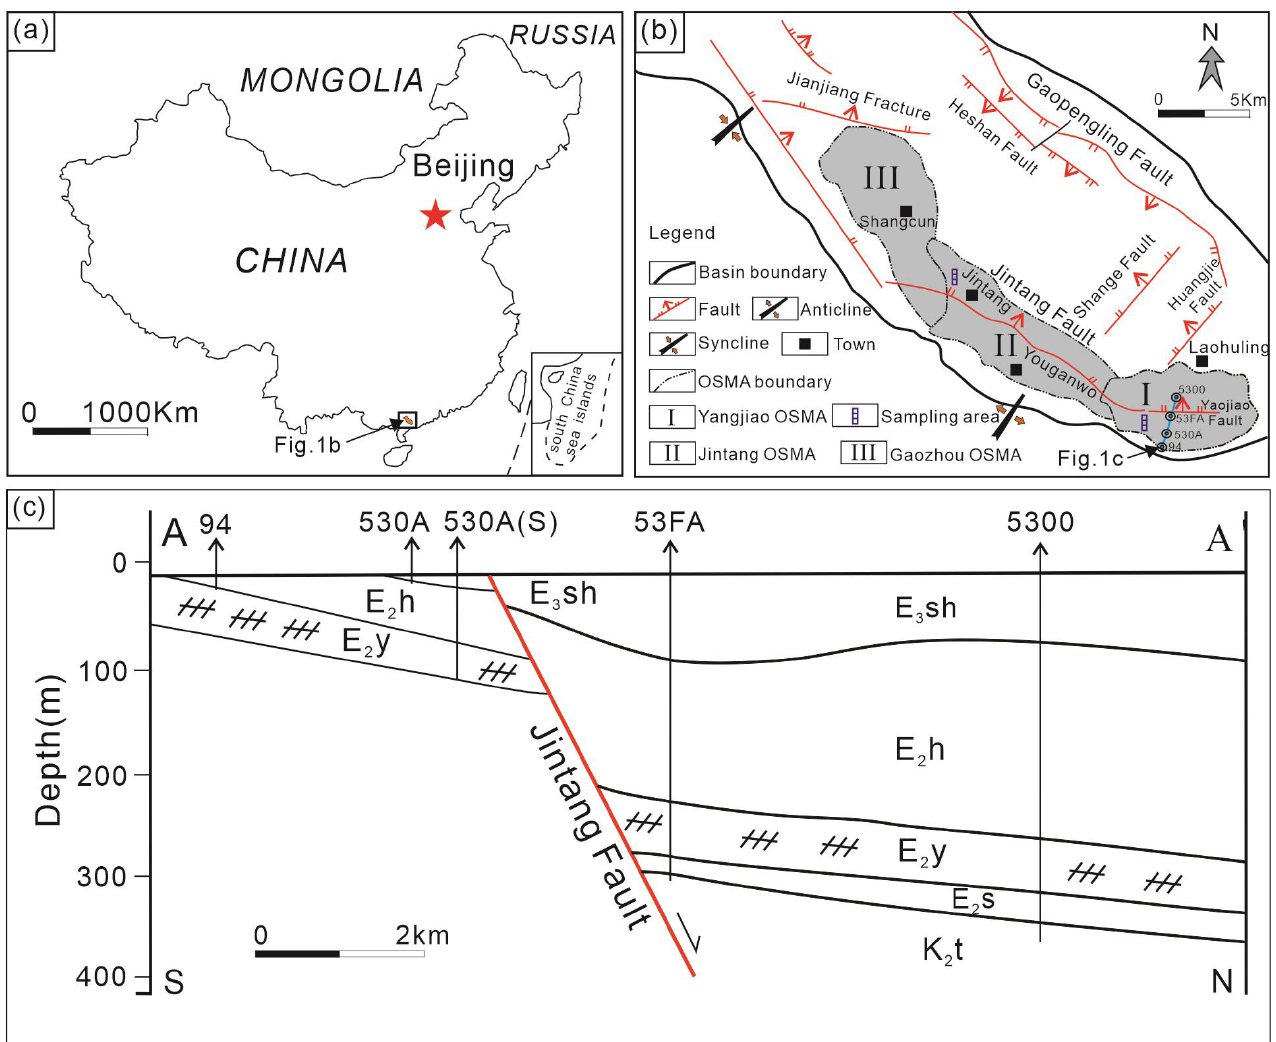
Figure 1. Regional location and mining area distribution map of Maoming Basin: ( a ) Location of Maoming Basin; ( b ) tectonic outline and oil shale mining areas distribution of Maoming Basin; ( c ) cross-sectional profiles of the study area showing the oil shale distribution controlled by the Jintang fault, locations of cross-sections are shown in ( b ). Abbreviations: OSMA, oil shale mining areas.